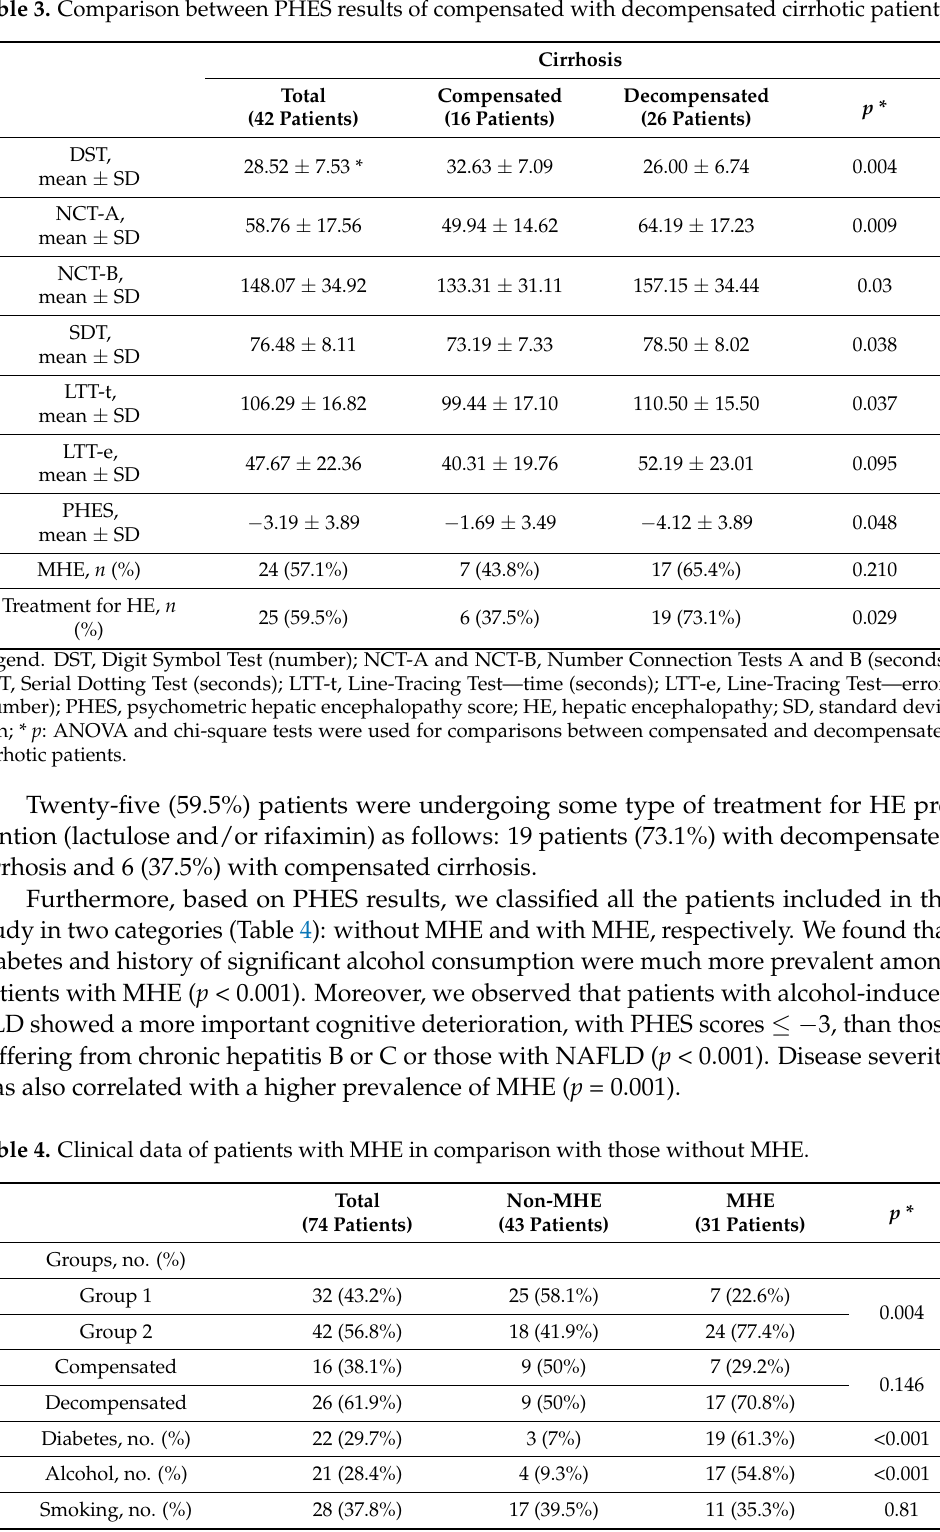
Table 3. Comparison between PHES results of compensated with decompensated cirrhotic patients.